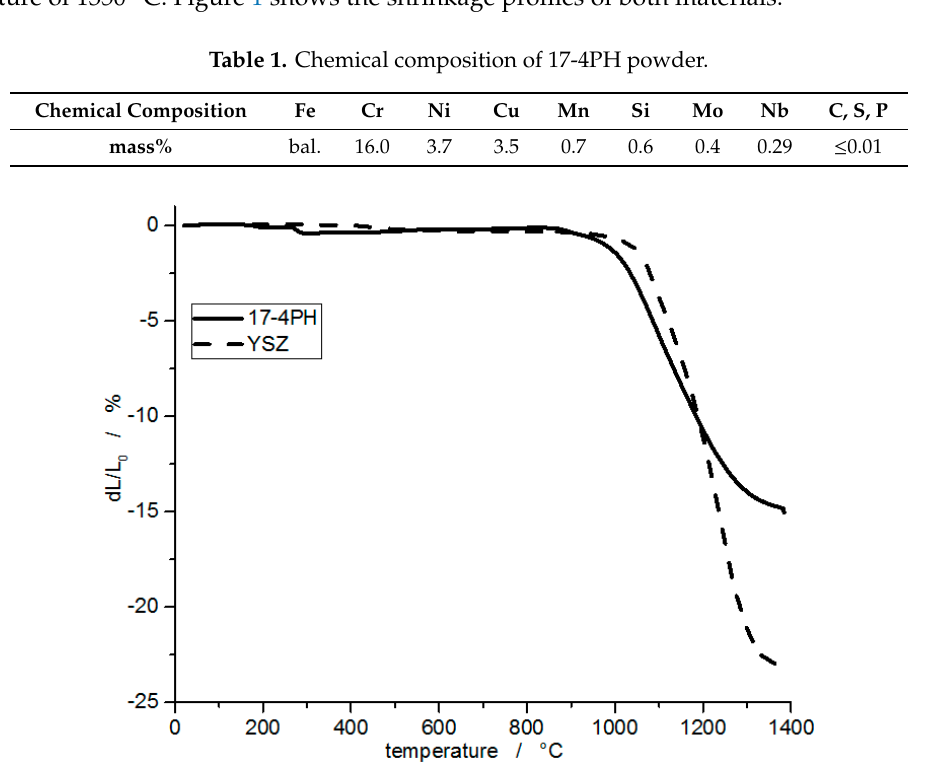
Figure 1. Shrinking behavior of YSZ and 17-4PH laminates during sintering in H 2 atmosphere.